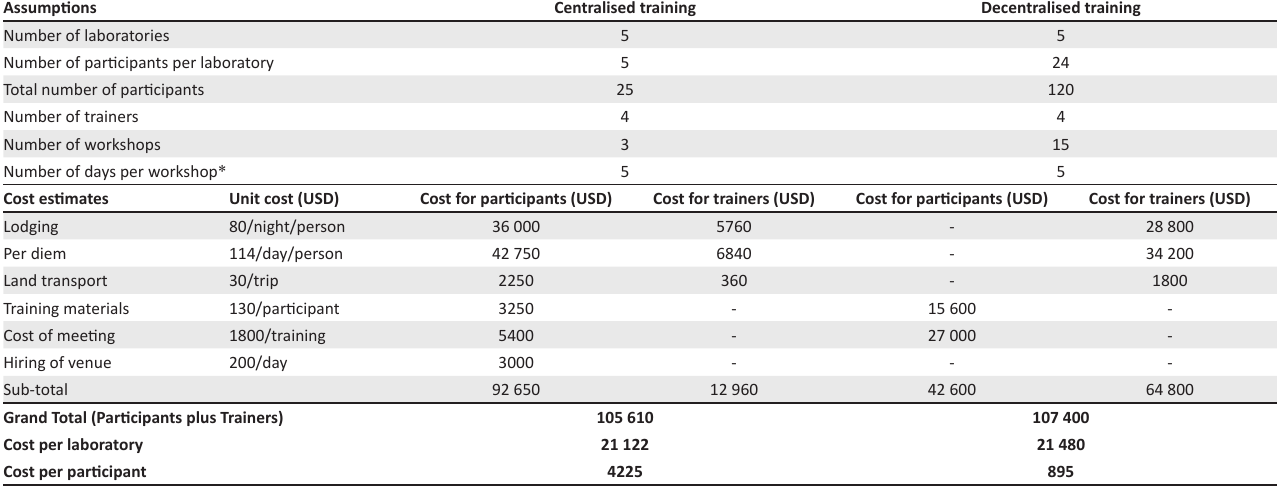
TABLE 2: Estimated cost in US dollars (USD) of conducting centralised versus decentralised SLMTA training workshops. Assumptions Centralised training Decentralised